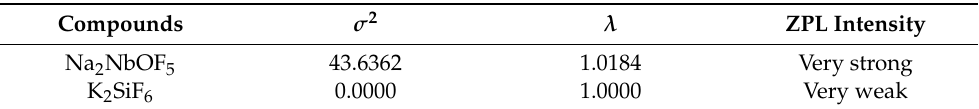
Table 2. Polyhedral distortion index and corresponding zero-phonon line (ZPL) intensities in Na 2 NbOF 5 and K 2 SiF 6 matrices. Compounds σ 2 λ ZPL Intensity Na 2 NbOF 5 43.6362 1.0184 Very strong K 2 SiF 6 1.0000 Very